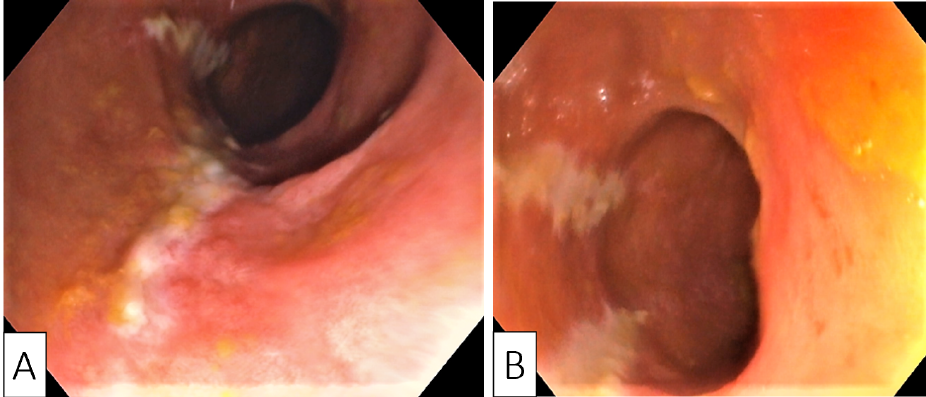
Figure 1. Endoscopic images showing longitudinal ( A ) and parallel ( B ) superficial ulcerations with surrounding mucosal edema and disappearance of colonic wall visible vascularization.